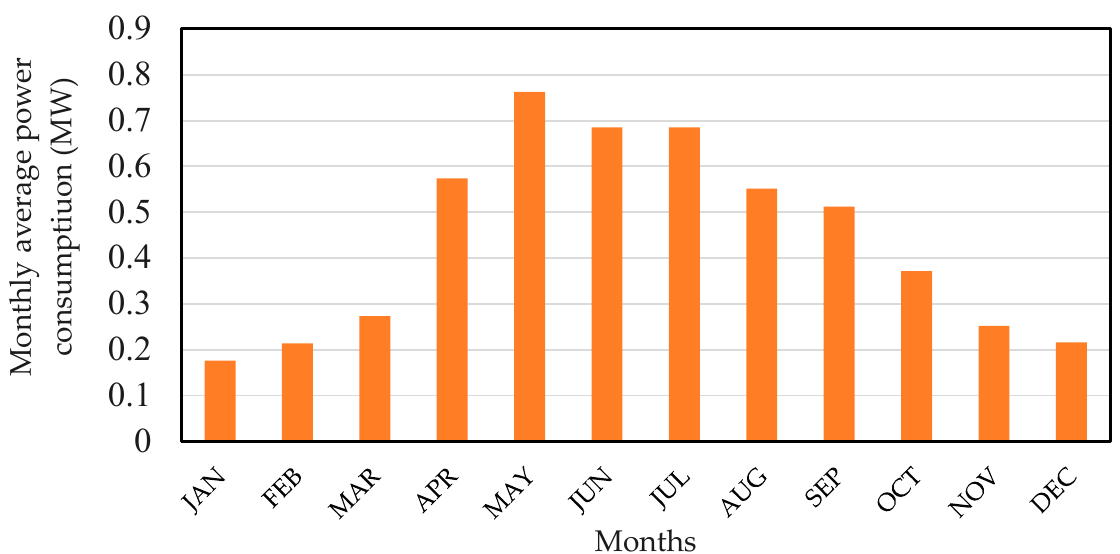
Figure 3. Monthly average electrical load power consumption in the Al-Dhafrat power distribution network.